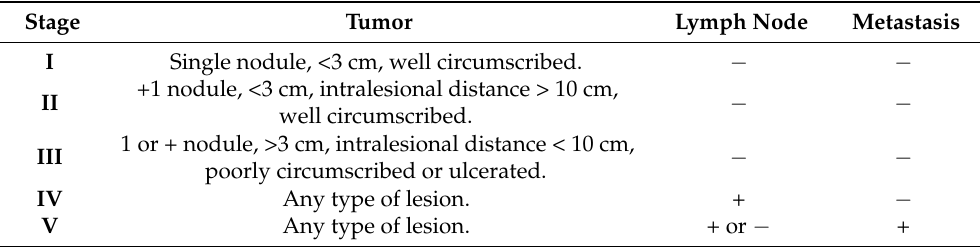
Table 2. Clinical Staging System for Canine Cutaneous MCT proposed by